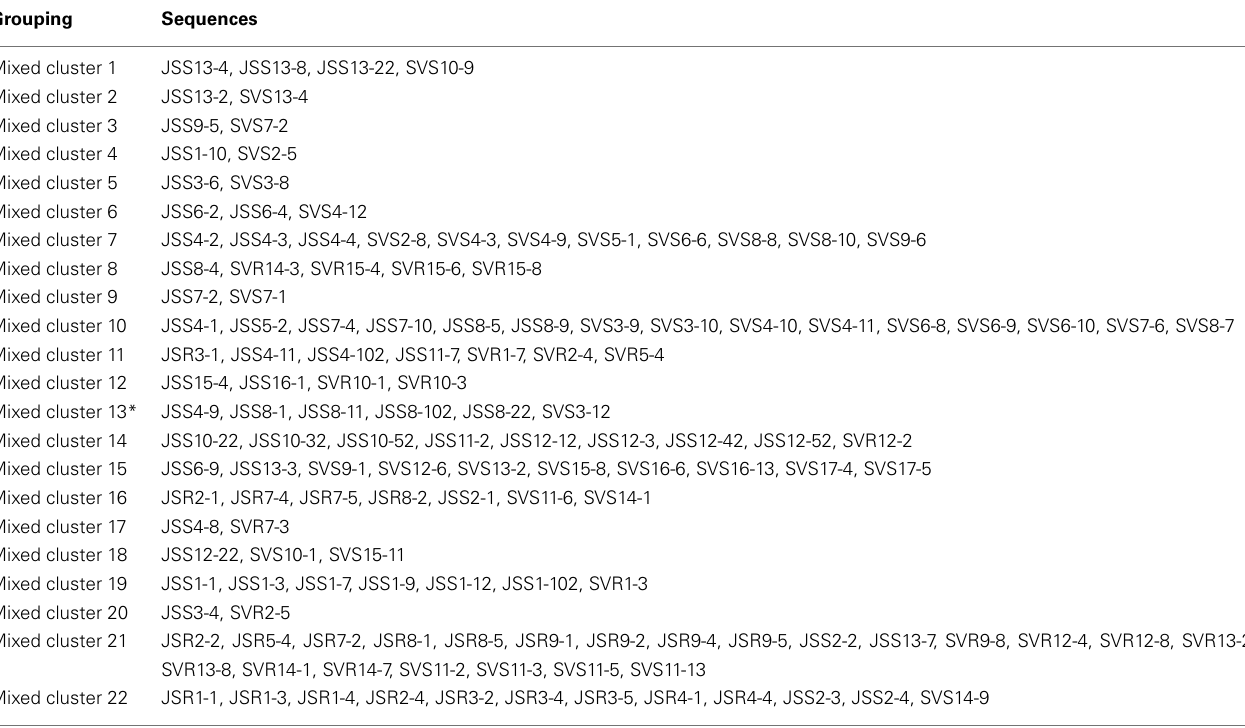
TableA1 | Sequences included in the mixed clusters designated in Figure 5 (* α - Proteobacteria